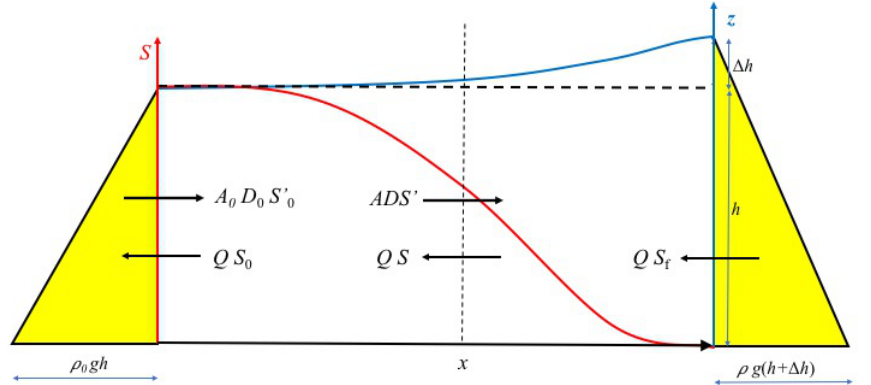
Figure 1. System description of the salt and fresh water mixing in an estuary, with the seaside on the left and the riverside on the right. The water level (blue line) has a slope as a result of the salinity distribution (red line). In yellow are the hydrostatic pressure distributions on both sides. The black arrows show the fluxes. Subscript “0” represents the downstream boundary